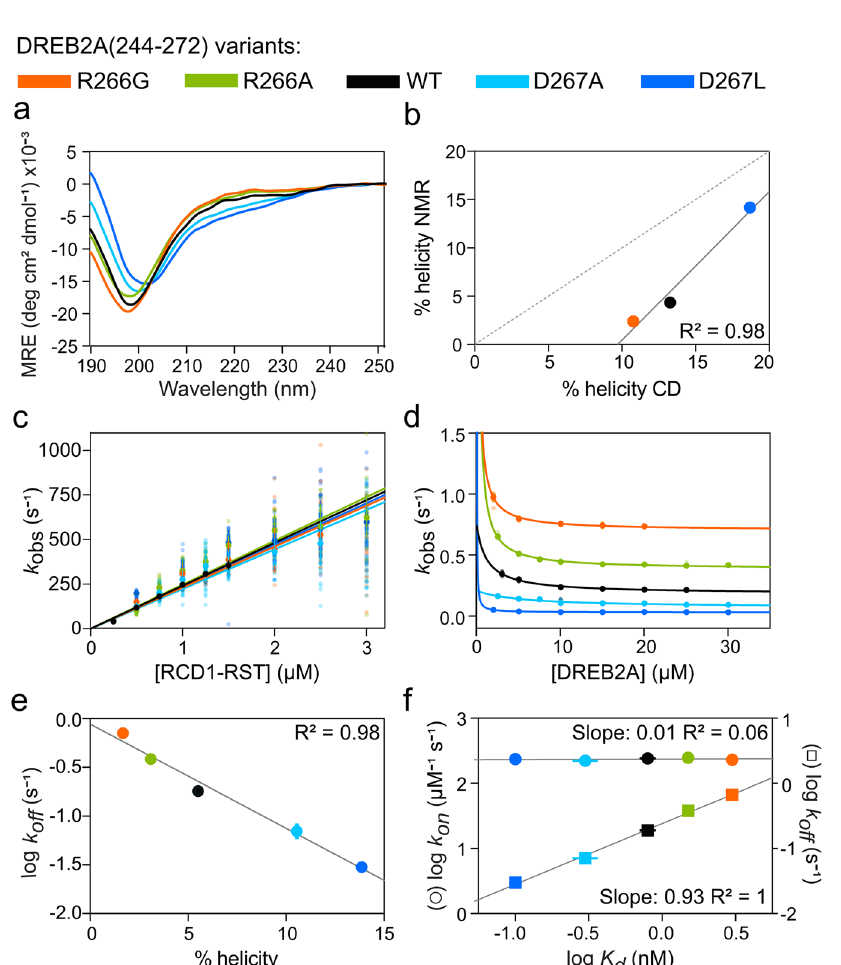
Fig. 3 Amount of residual helicity of DREB2A(244-272) variants correlates with complex structure and lifetime. Analysis of DREB2A(244-272)-WT and variants R266G, R266A, D267A, and D267L. a Far-UV (190-250 nm) CD spectra of DREB2A variants at 0% (v/v) TFE. All spectra were recorded on 24 µ M peptide in 10 mM Na 2 HPO 4 /NaH 2 PO 4 pH 7.0, 25 °C, and are an average of 10 scans. Raw data available as Supplementary Data 3. b Correlation between amount of α -helix in free DREB2A variants measured by NMR and CD spectroscopy. A standard curve was generated by linear regression (Y = 1.538x-14.93). The dashed line represents a perfect 1:1 correlation. c Association and d dissociation kinetics recorded by stopped- fl ow fl uorescence spectroscopy at 10 °C in 50 mM HEPES pH 7.4, 100 mM NaCl buffer. All individual data points are shown and error bars represent standard deviation from repetitions. Raw data available as Supplementary Data 4. e Correlation between dissociation kinetics and α -helix content calculated from the standard curve. f LFER plot showing the relationship between k on and k off and K d upon substitution. Linear regression of log k on and log k off is shown. Error bars represent standard error from fi